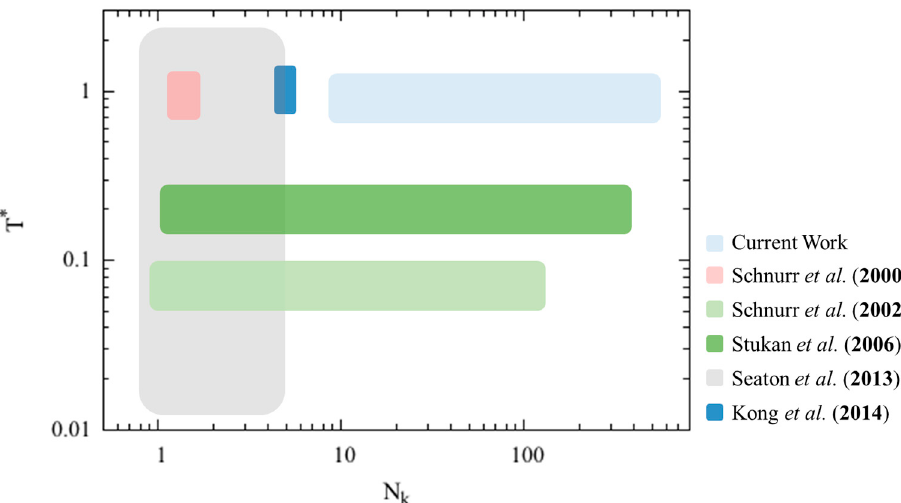
Figure 1. Illustrative phase diagram of the parameter space that has been covered in previous simulations and theoretical models in the literature, and in this work. The x -axis is the Kuhn length ( N k ) of the polymer chain, and the y -axis is the dimensionless temperature, defined as the k B T divided by the attractive energy per monomer bead used in each study.